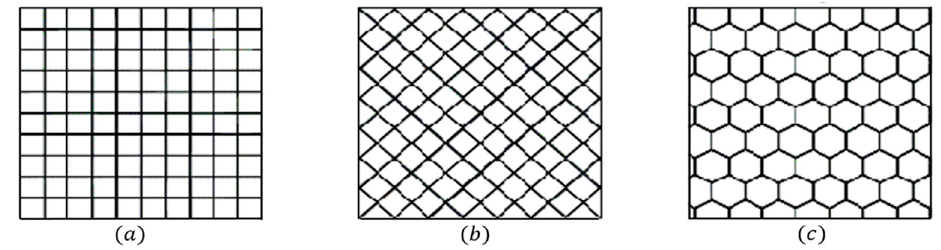
Figure 1. Build orientation: ( a ) numerical; ( b ) categorical [11]. 87 Figure 2. Infill pattern: ( a ) linear; ( b ) diamond; ( c ) hexagonal [20]. 99